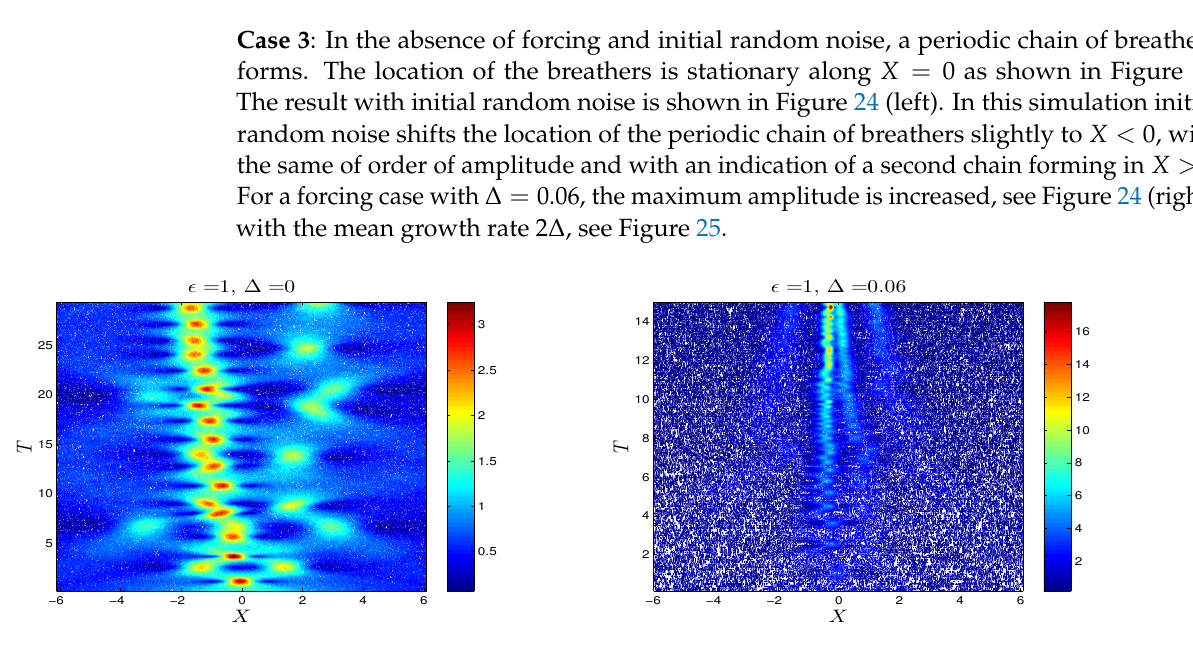
Figure 24. Initial random noise, Case 3: Contour plots of | Q | when ∆ = 0 ( left ) and ∆ = 0.06 ( right ).